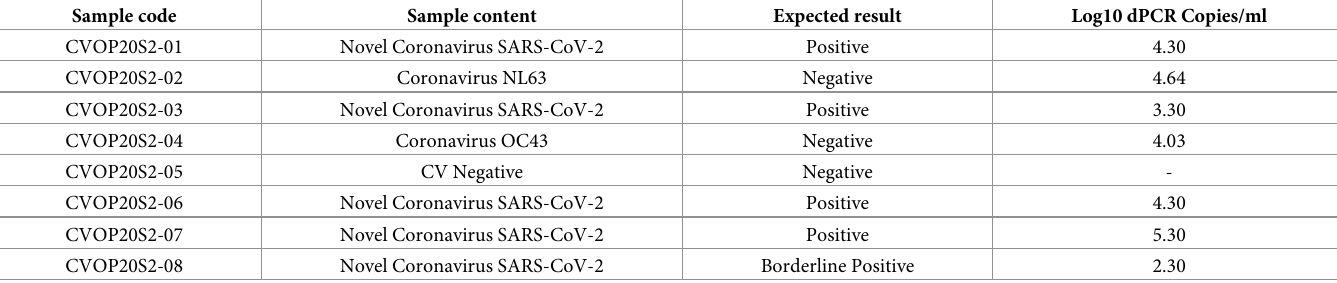
Table 3. Sample content of the EQA Pilot study. Sample code : QCMD panel sample codes for the samples distributed to laboratories. Sample content : Content of the individual panel samples and, where applicable, the subtype or stain of the pathogen. Expected result : Expected outcome when testing for SARS-CoV-2. Log10 dPCR Cop- ies/ml : The value obtained using a digital droplet PCR assay (modified from [14]). Samples CVOP20S2-07, 01, 03, 08, are in a calibrated dilution series. CVOP20S2-06 is a duplicate sample of CVOP20S2-01. Sample code